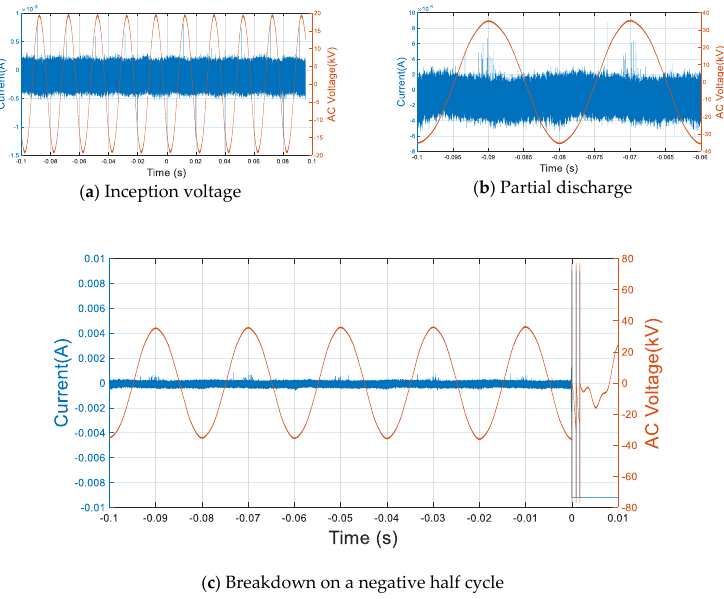
Figure 8. Voltage-current waveform for measuring inception voltage, partial discharge, and breakdown voltages (4%Novec TM 4710/96%CO 2 , P = 1 bar abs).